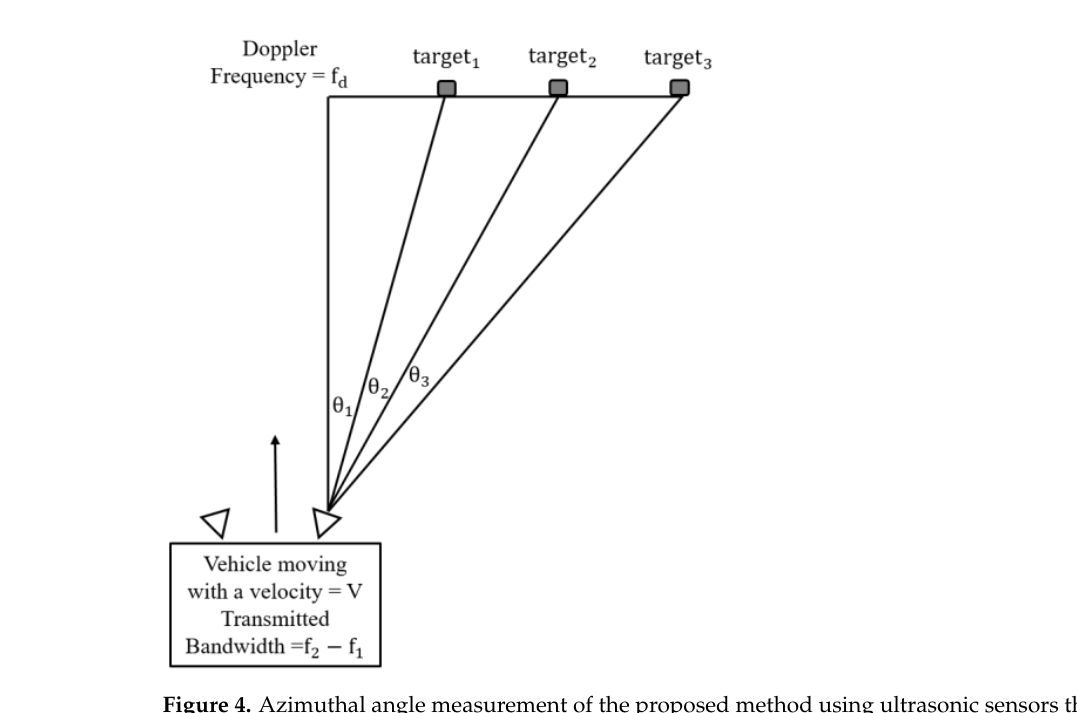
Figure 4. Azimuthal angle measurement of the proposed method using ultrasonic sensors through Doppler shift.